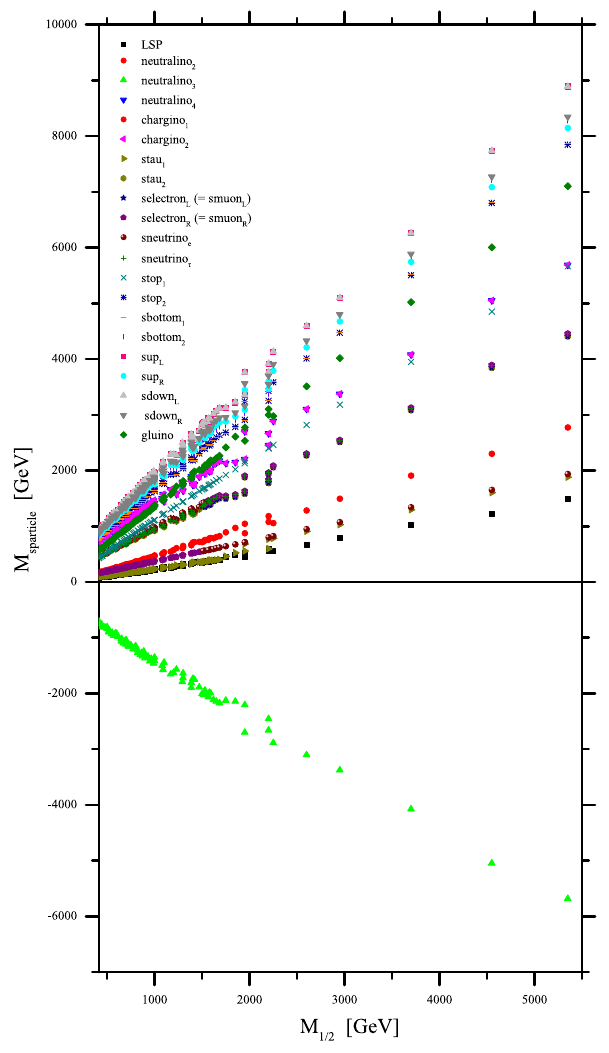
Fig. 1 Defining relationship amongst the sole model parameter M 1 / 2 and the SUSY particles. The linear dependence of all SUSY masses on M 1 / 2 emerging from No-Scale SUGRA is clear. Only actual computed points are plot, borrowed from all the benchmark sets published in